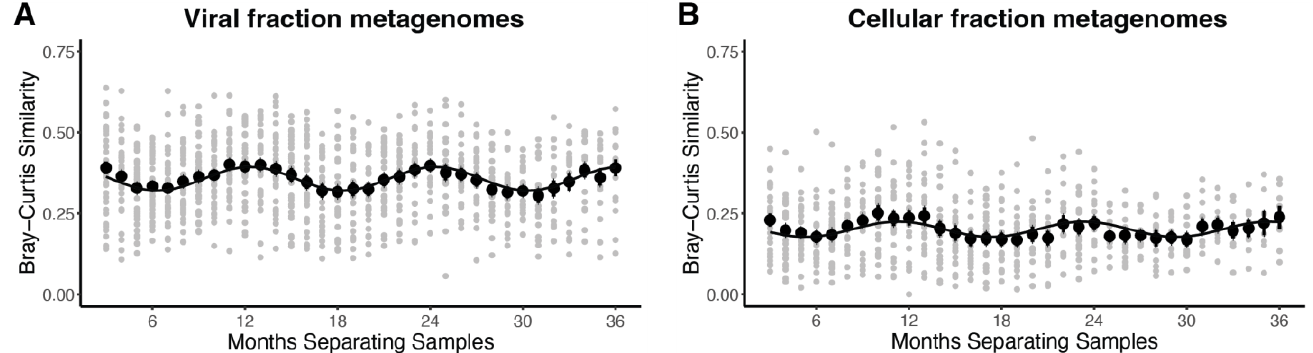
Figure 1. Seasonality of whole T4-like cyanophage community is evidenced by Bray – Curtis (BC) similarity scores (gray points) of cyanophage communities as a function of months separating samples. Black points show average BC similarity values. Errors bars are standard error. The black line is a sine fit to average BC values. ( A ) T4-like cyanophages found in viral fraction metagenomes. p -value for sine fit = 9.90 × 10 − 13 . ( B ) T4-like cyanophages found in cellular fraction metagenomes. p -value for sine fit = 2.20 × 10 − 5 .